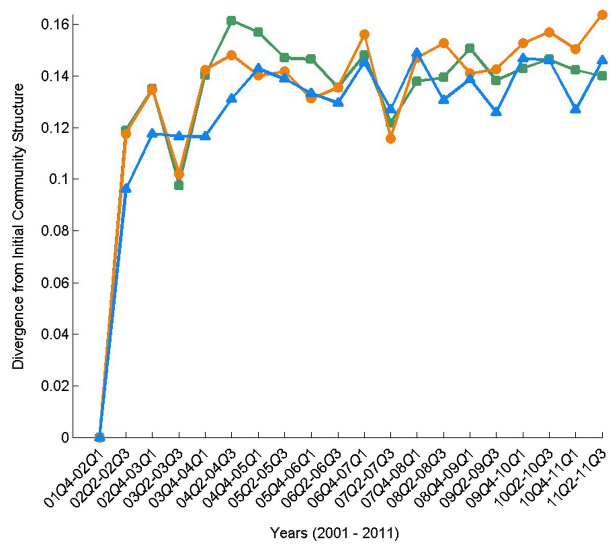
FIG. 20. Heat map showing the value of VI between every pair of six-month time windows, as well as the VI between each window and the total ten-year period (leftmost column and top row). Most notably, there is a slight increase in the similarity of the communities of the last five periods from 2009 – 2011 (produced using the Louvain